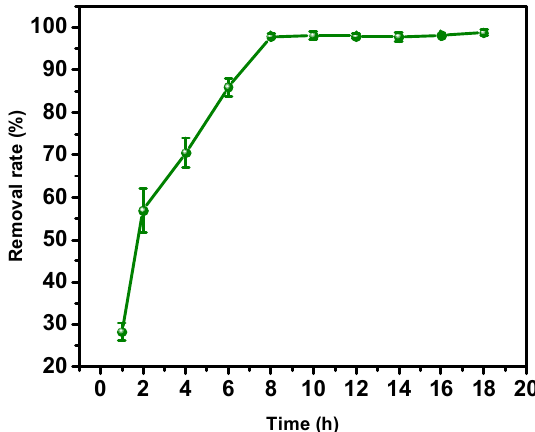
Figure 9. The removal rate of Pb 2+ at different adsorption times. (Experimental conditions: pH = 6, MnO 2 /Mxene composite films 12 mg, solution volume 100 mL, C Pb 2 + = 30 mg/L, 25 ◦